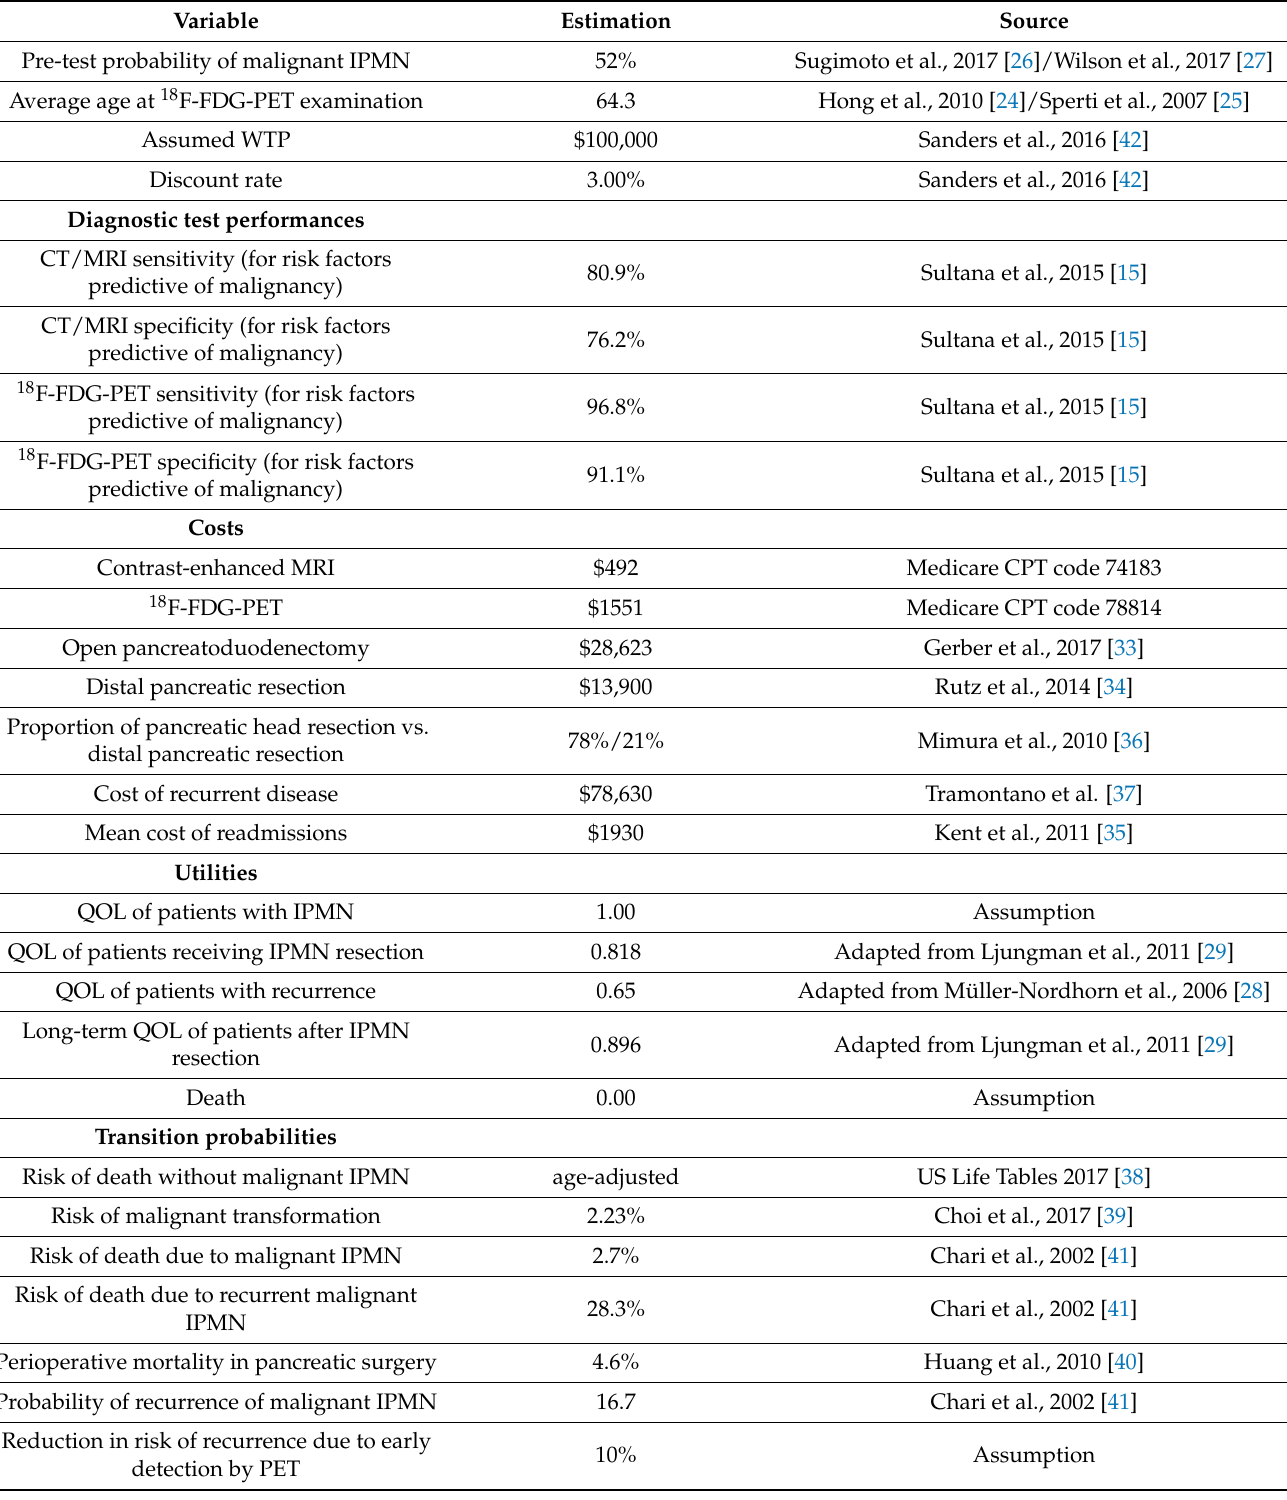
Table 1. Input parameters for the Markov decision